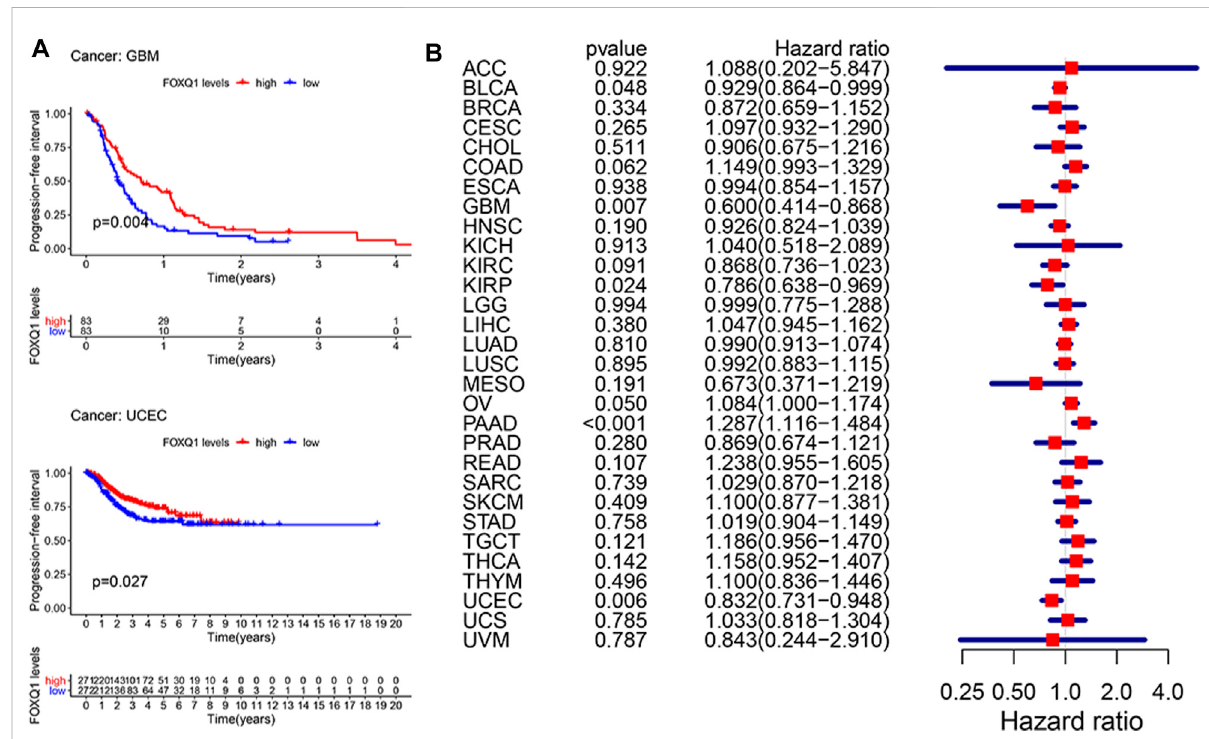
FIGURE 5 CorrelationofforkheadboxQ1(FOXQ1)expressionwithprogress-freesurvivalinpan-cancer. (A) Kaplan – MeiercurvebasedFOXQ1expression in cancer. The red color represents high expression, and the blue color represents low expression. (B) forest plot for the progress-free survival analysis of FOXQ1 in